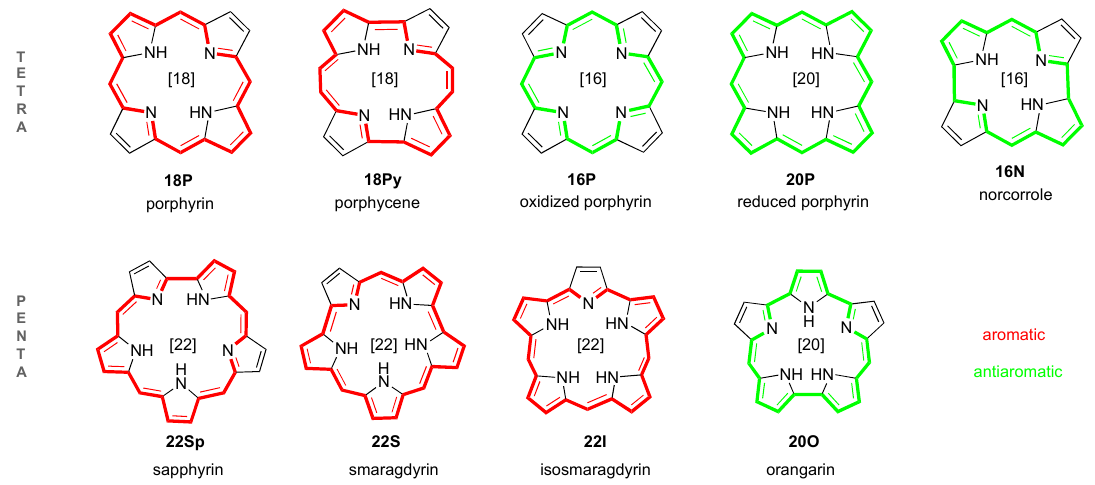
Figure 1. Selected Hückel porphyrinoids and their expected aromaticity according to the annulene model. The annulene-type conjugation pathway is depicted with bold colored bonds.